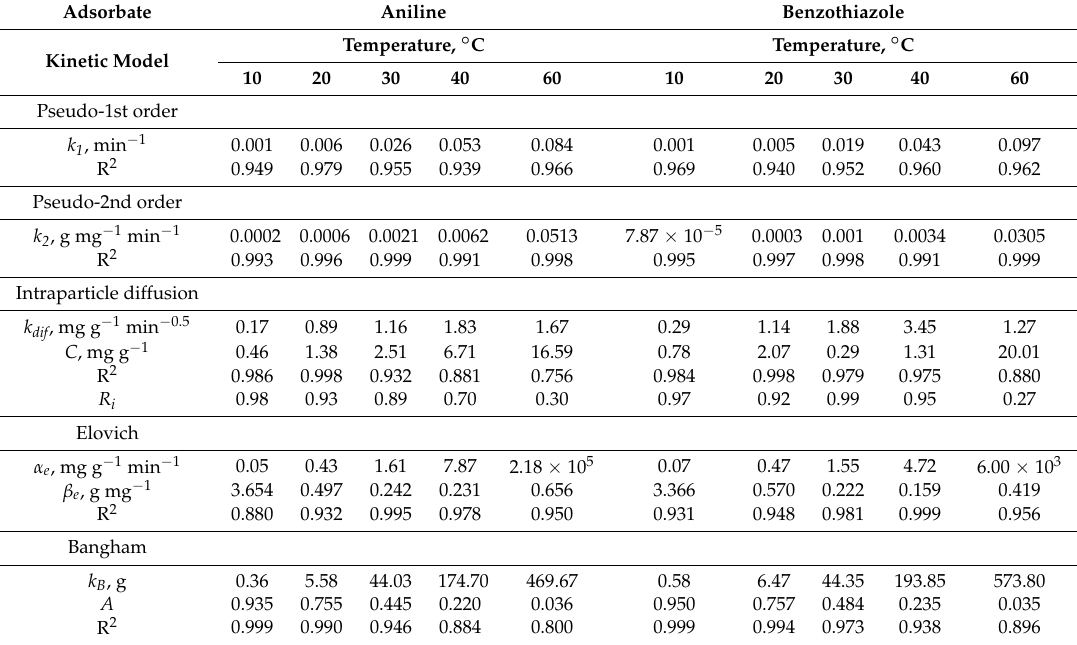
Table 3. Kinetic parameters for the adsorption of aniline or benzothiazole onto TiO 2 at different